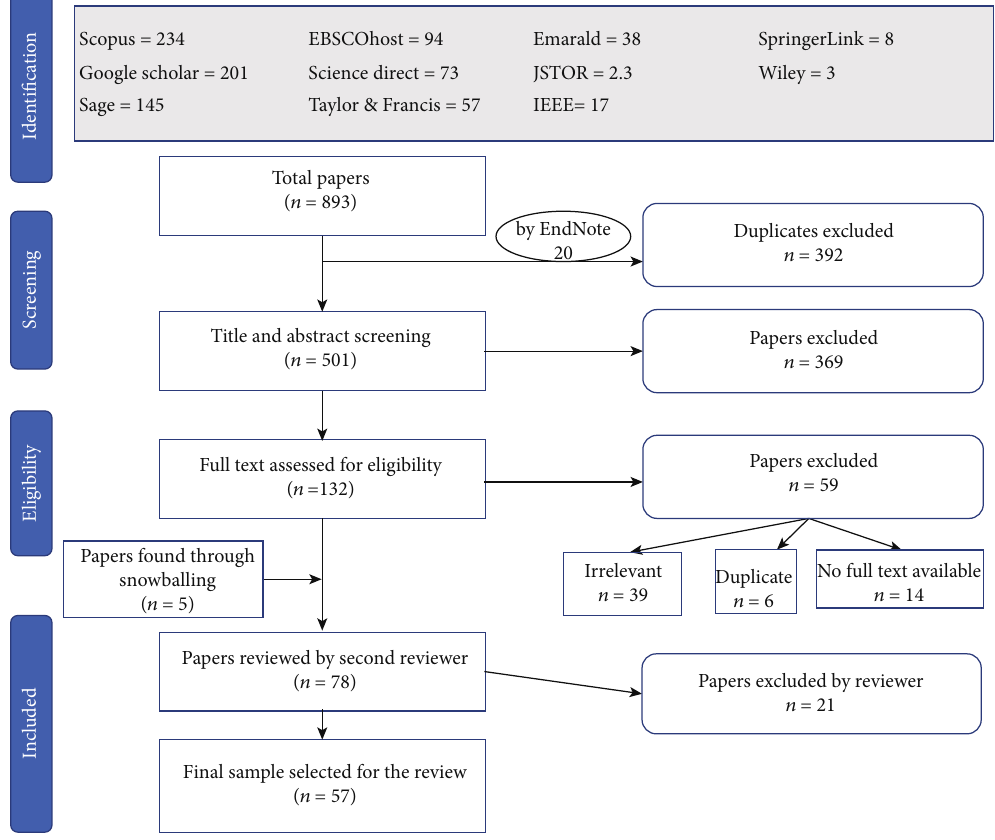
Figure 3: Paper selection